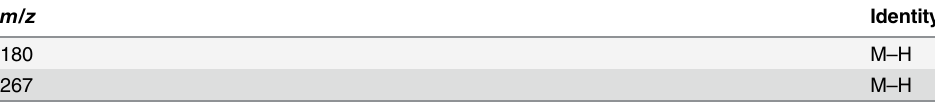
Table 5. Liquid chromatogram-mass spectrum (LC-MS) protonated molecular ion for product